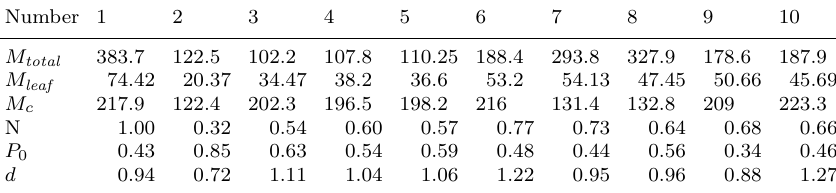
Table 3. The simulation results for species (a).